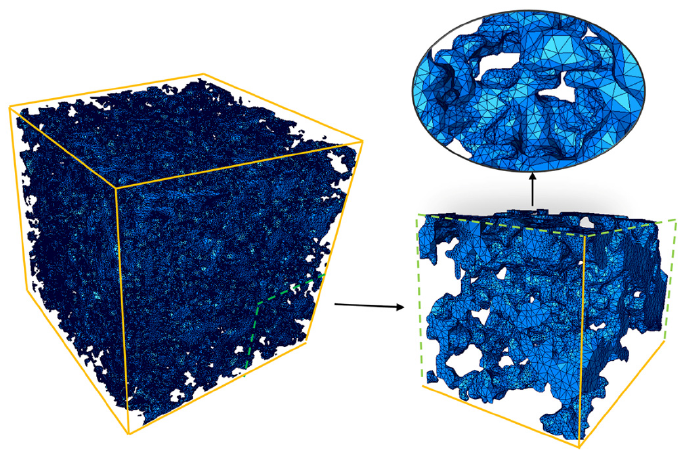
Figure 8. 3D solid mesh model.